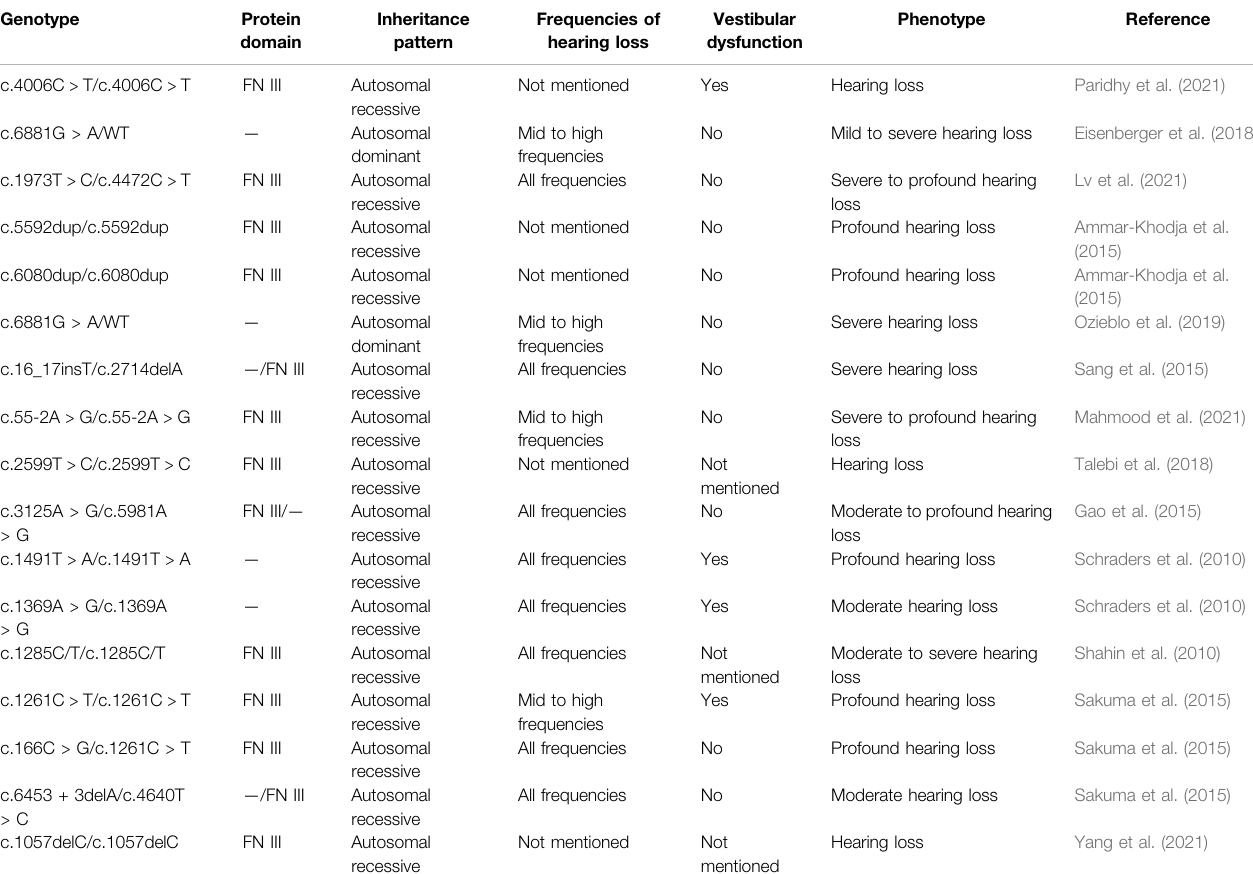
TABLE 2 | PTPRQ mutations with hearing phenotypes in families.